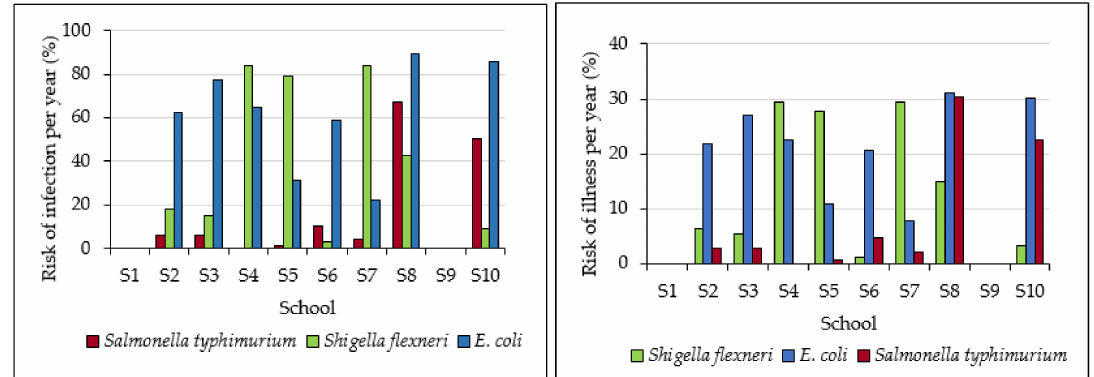
Figure 7. Risks of infection and illness per